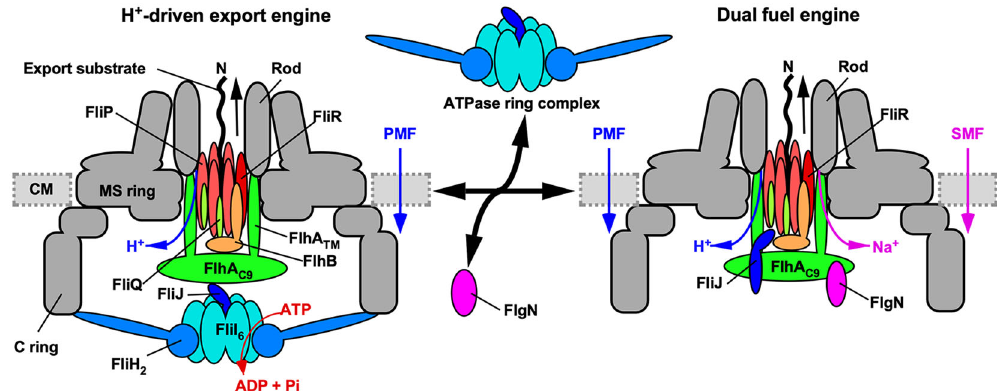
Fig. 6 Schematic diagram of the fl agellar protein export machinery. The fl agellar protein export machinery is composed of a transmembrane export gate complex made of FlhA, FlhB, FliP, FliQ, and FliR and a cytoplasmic ATPase complex consisting of FliH, FliI, and FliJ. The export gate complex is located inside the MS ring and utilizes proton motive force (PMF) across the cytoplasmic membrane (CM) to drive proton (H + )-coupled fl agellar protein export. FliP, FliQ and FliR form a polypeptide channel. FlhB associates with the FliP/FliQ/FliR complex and controls opening of the polypeptide channel. The C- terminal cytoplasmic domain of FlhA (FlhA C ) projects into the central cavity of the C ring. The N-terminal transmembrane domain (FlhA TM ) forms an ion channel for the translocation of H + and sodium ion (Na + ) from the periplasm to the cytoplasm. The cytoplasmic ATPase ring complex associates with the C ring through an interaction between FliH and a C ring protein, FliN. ATP hydrolysis by the FliI ATPase activates the export gate complex through an interaction between FliJ and FlhA L connecting FlhA C to FlhA TM , becoming an active protein transporter to couple the H + fl ow through the FlhA channel to the translocation of export substrates into the polypeptide channel. When the cytoplasmic ATPase complex does not function properly, FlgN binds to FlhA C to open the Na + channel of FlhA TM , allowing the export gate complex to utilize sodium motive force (SMF) across the cytoplasmic membrane to drive Na + -coupled protein